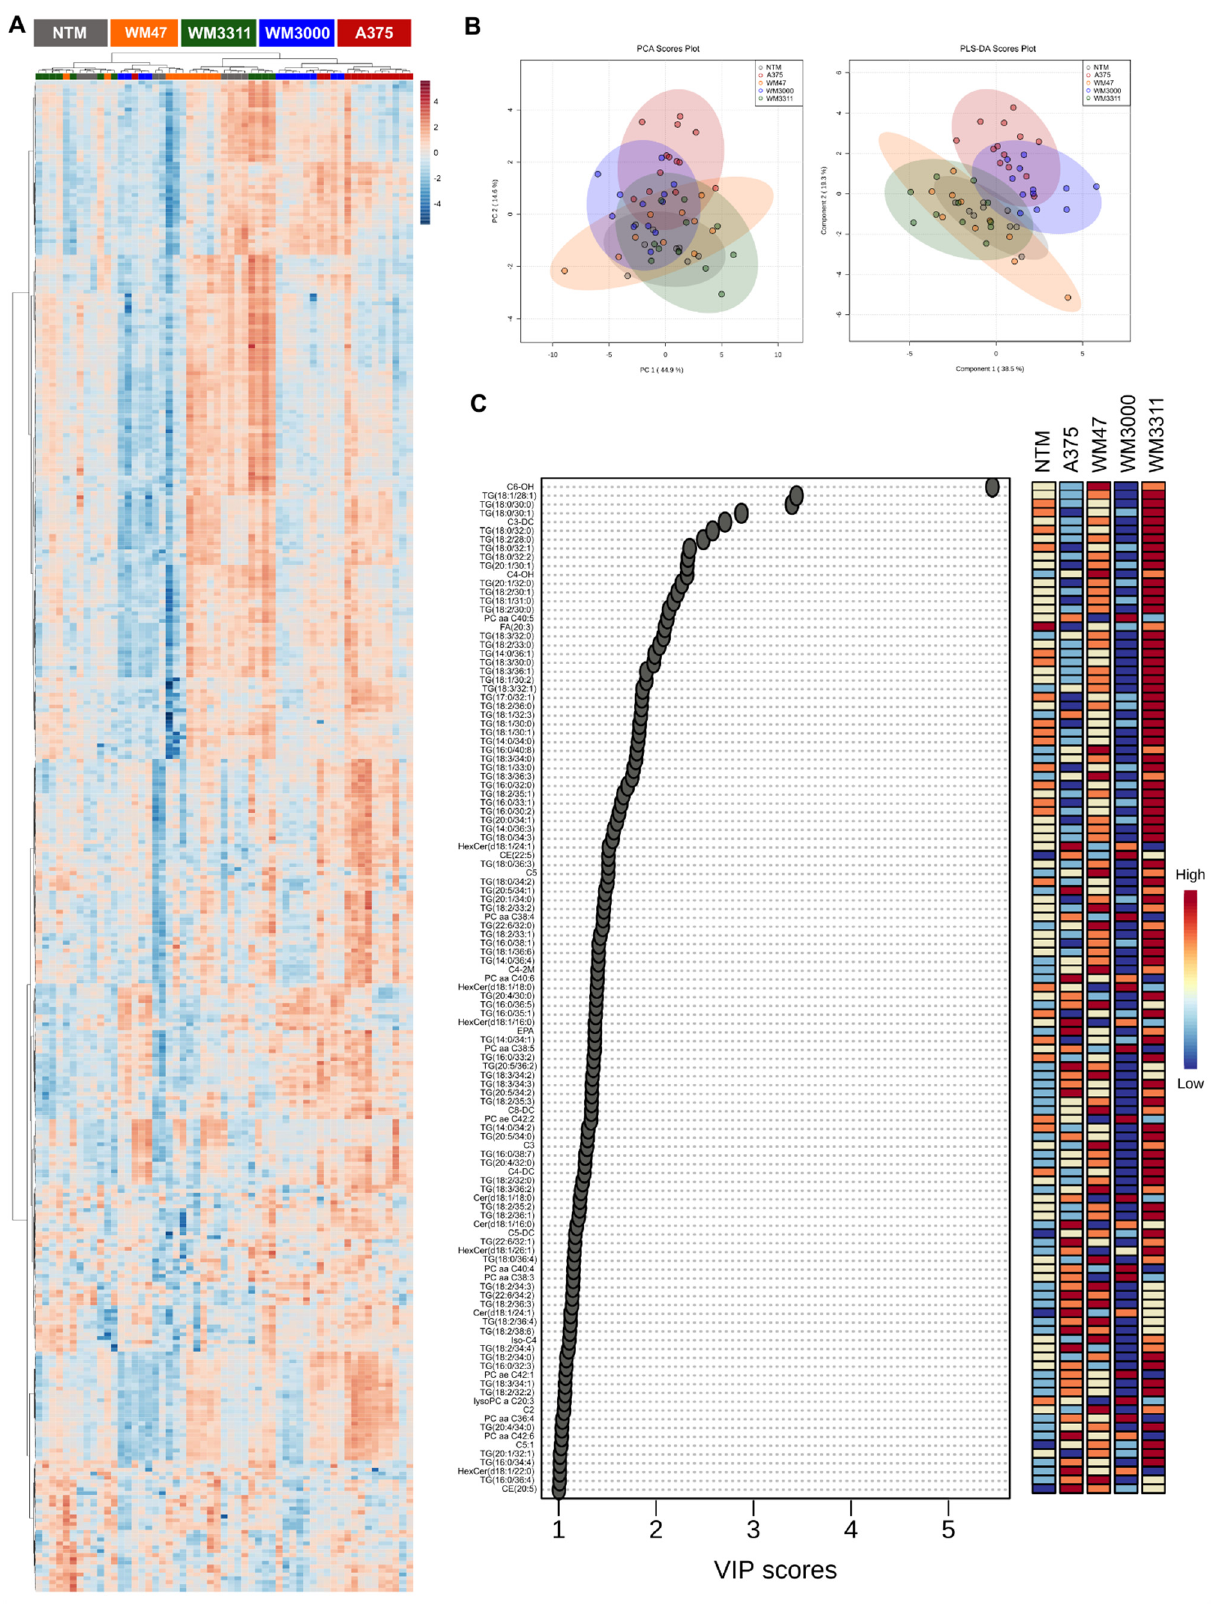
Figure 7. Metabolic analysis of lipids and lipid-like metabolites in plasma. ( A ) Heatmap, ( B ) PCA and PLS-DA scores, and ( C ) PLS-DA VIP score derived from the lipids and lipid-like metabolite profiling data of plasma samples from mice bearing A375, WM47, WM3000, and WM3311 melanoma xenografts and non-tumor mice. n = 9–13; aa: acyl-acyl, ae: acyl-alkyl, Cx:y:x = number of carbons in the fatty acid side chain and y = number of double bonds in the fatty acid side chain, C2: